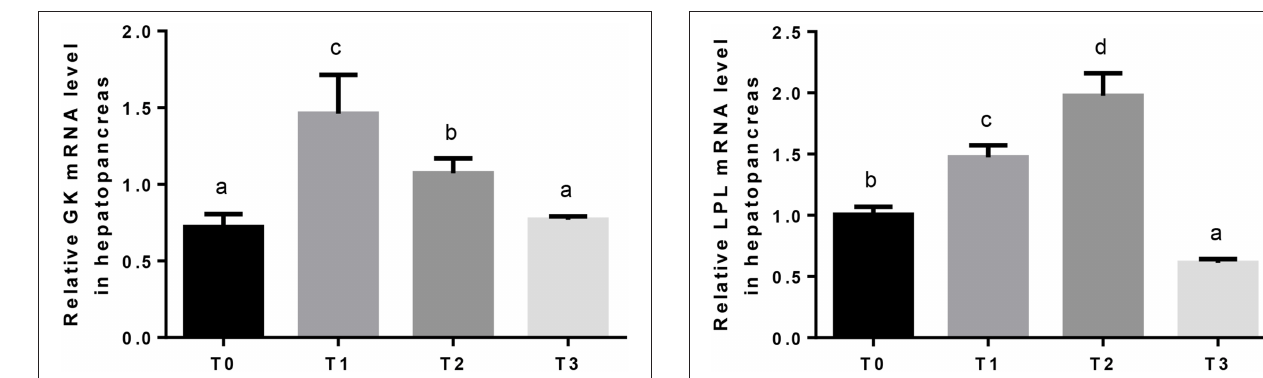
FIGURE 2 | The relative expression of GK mRNA in the hepatopancreas. The letters indicate the results of multiple range test, the different letters indicated significant differences ( P < 0.05).